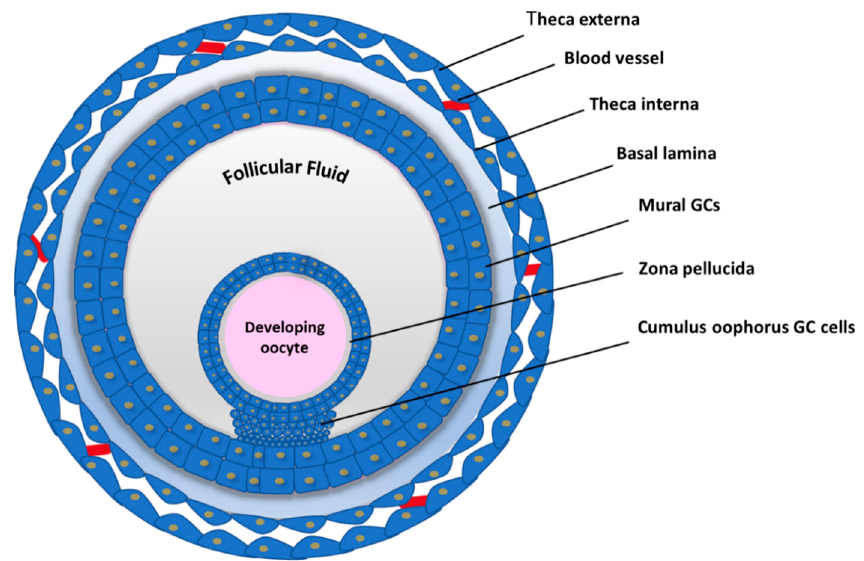
Figure 1. Schematic representation of the Ovarian Follicle structure.